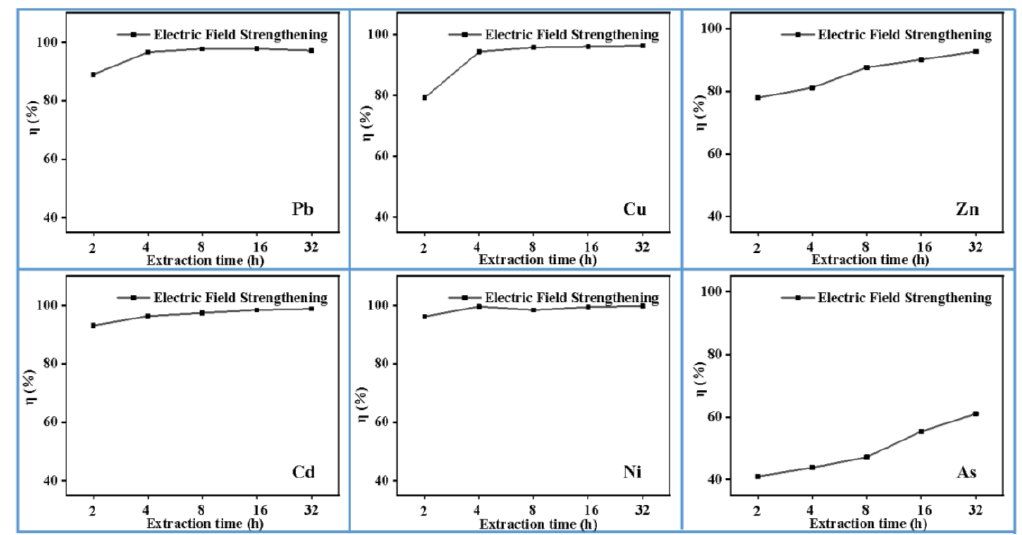
Figure 6. Effect of extraction time on heavy metals efficiency (0.5 mol/L EDTA, 35 mA/cm 2 , pH = 2, 0 Hz).